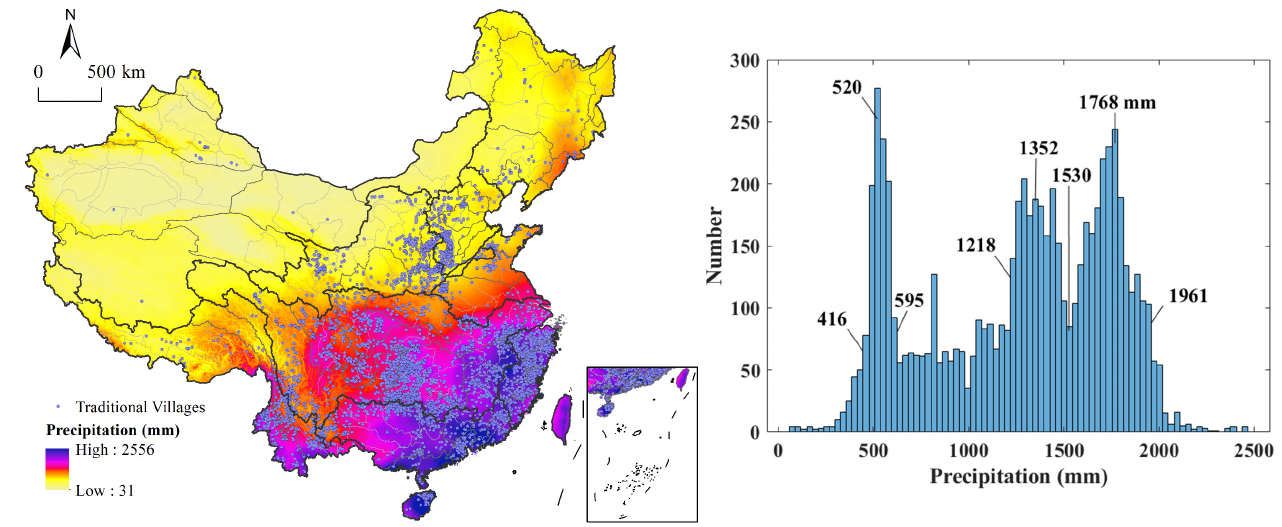
Figure 4. Relationships between traditional villages and annual precipitation in China.